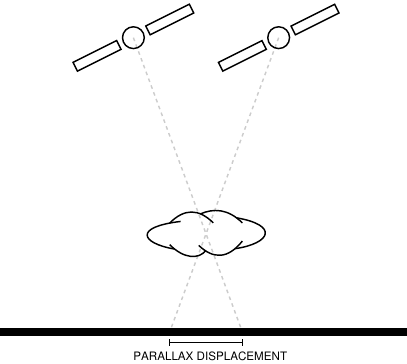
Figure 1. The clouds, at higher altitude than the ground, result in an apparent displacement relative to the ground due to